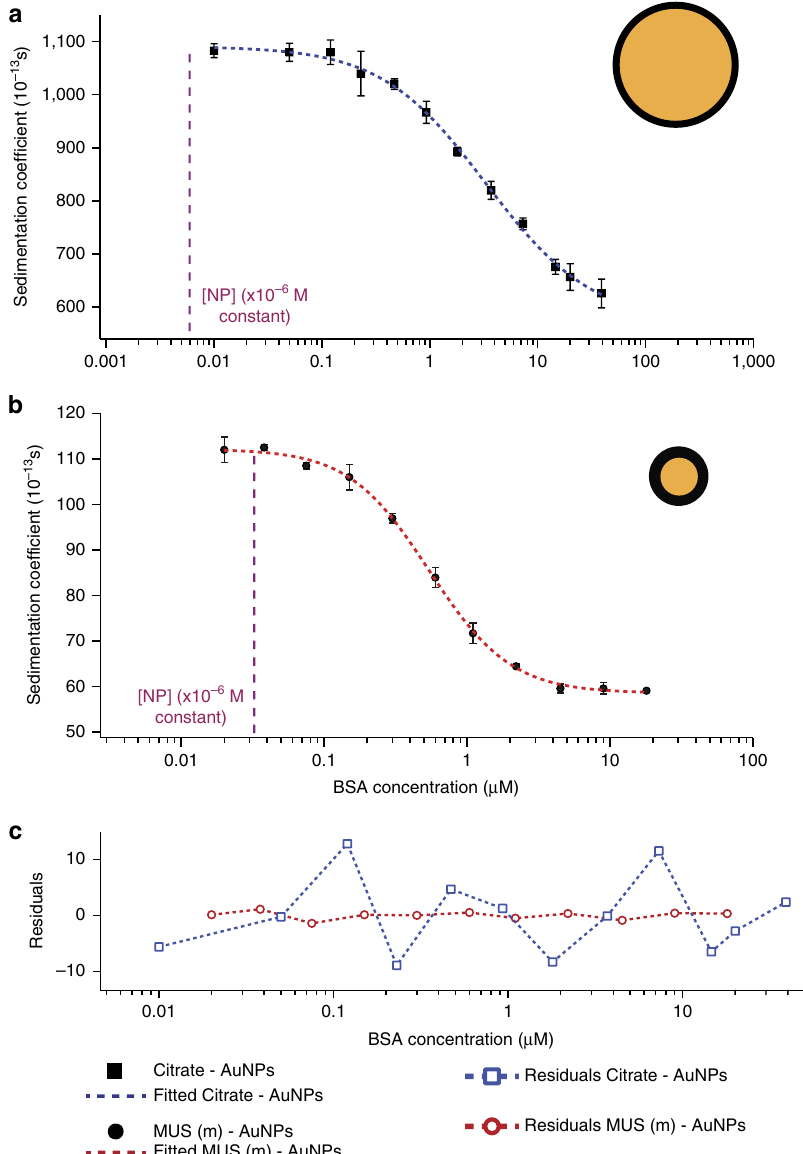
Figure 2 | SV-AUC binding isotherms for Citrate-AuNPs and MUS(m)-AuNPs with BSA. Plots of average s versus BSA concentration for ( a ) citrate– AuNPs ( d H ¼ 13.6nm) and ( b ) MUS(m)–AuNPs ( d H ¼ 7.6nm). Dashed lines are fits obtained using equation (6). ( c ) Residuals of the fit functions are plotted against BSA concentration. Dashed magenta line indicates the nanoparticle concentration kept constant during experiments. Error bars represent the standard deviation of three independent measurements from the same batch of NPs.